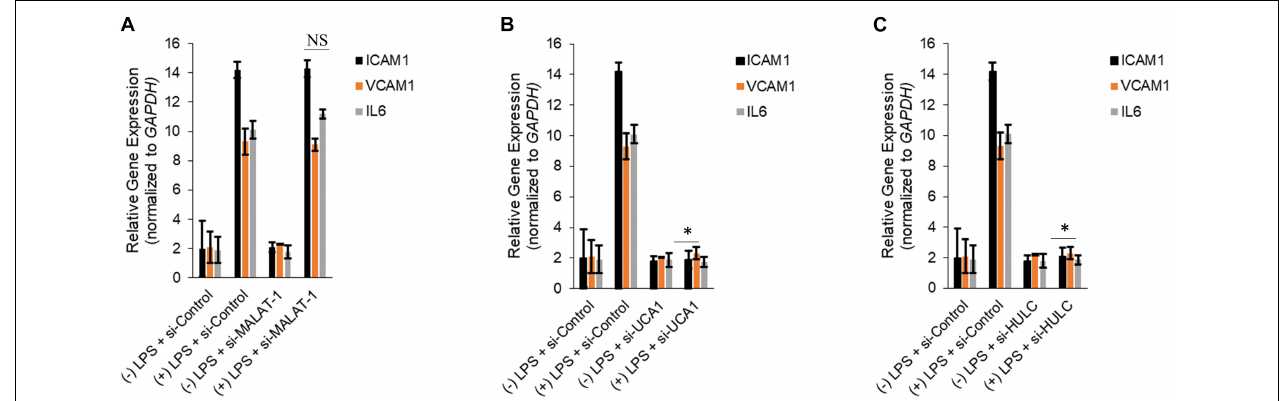
FIGURE 4 | Downregulation of UCA1 and HULC, but not MALAT-1, using siRNAs inhibits sepsis associated induction of ICAM1 , VCAM1 , and IL6 . Expression of ICAM1 , VCAM1 , and IL6 mRNAs were determined by qRT-PCR in HMECs, either mock transfected or transfected with siRNAs targeting MALAT-1 (A) , UCA1 (B) , and HULC (C) . Data represent mean ± standard deviation of three independent experiments, post-normalization to GAPDH expression. ∗ P < 0.05, compared to LPS treated HMECs with no siRNA transfection.